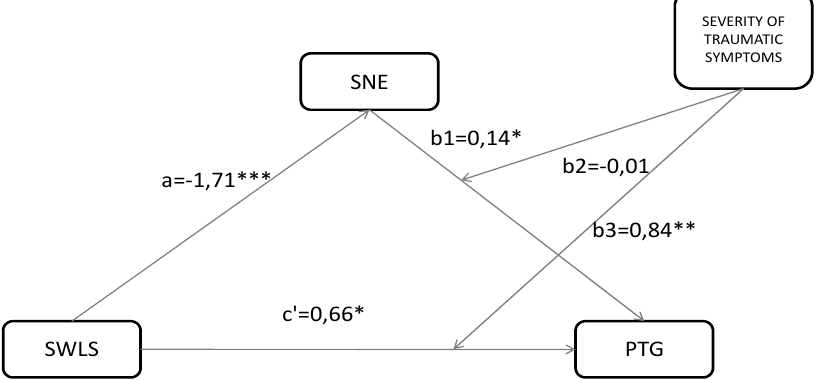
Figure 2. Mediation-moderation model among severity of PTSD symptoms, existential anxiety (SNE), life satisfaction (SWLS), and post-traumatic growth (PTG). * p < 0.05; ** p < 0.001; *** p <